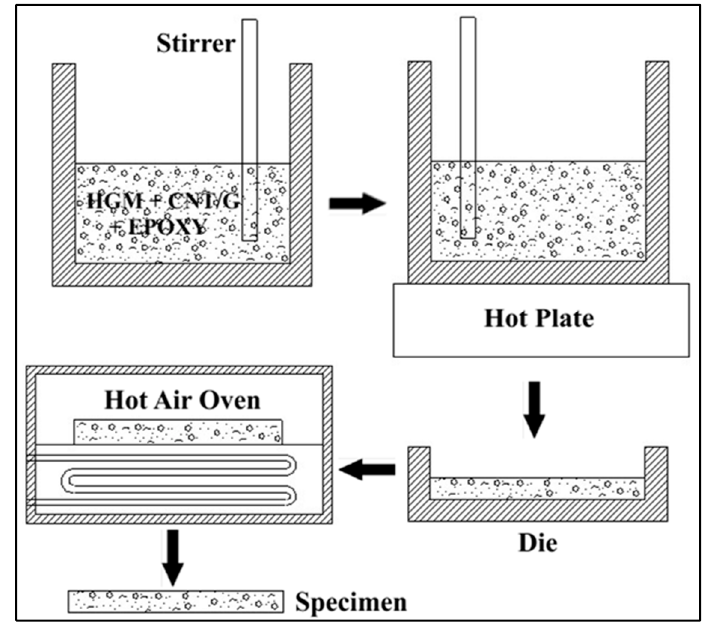
Figure 1. Flow diagram of composite fabrication.